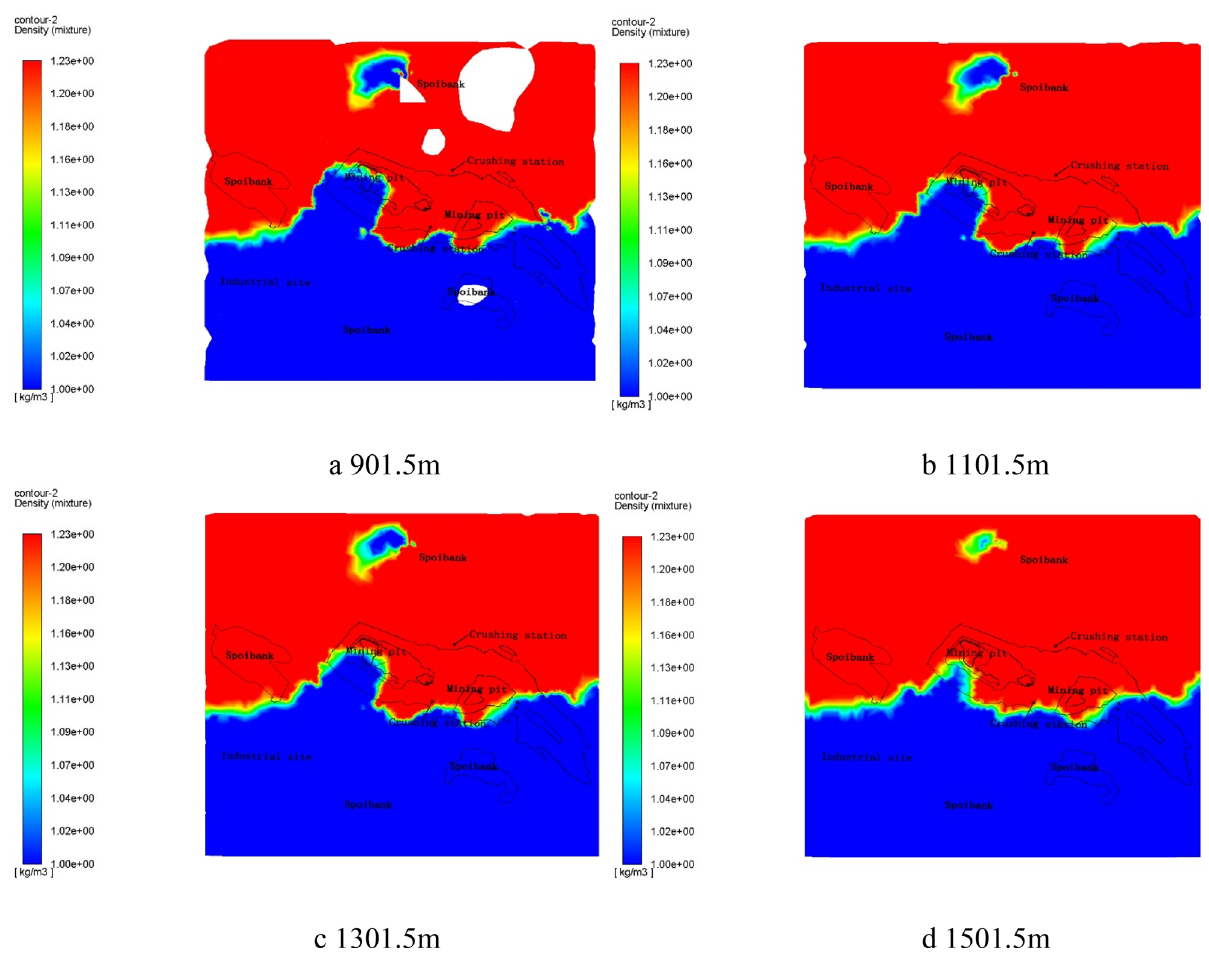
Figure 7. Dust distribution map under windy condition by Fluent 13.0.